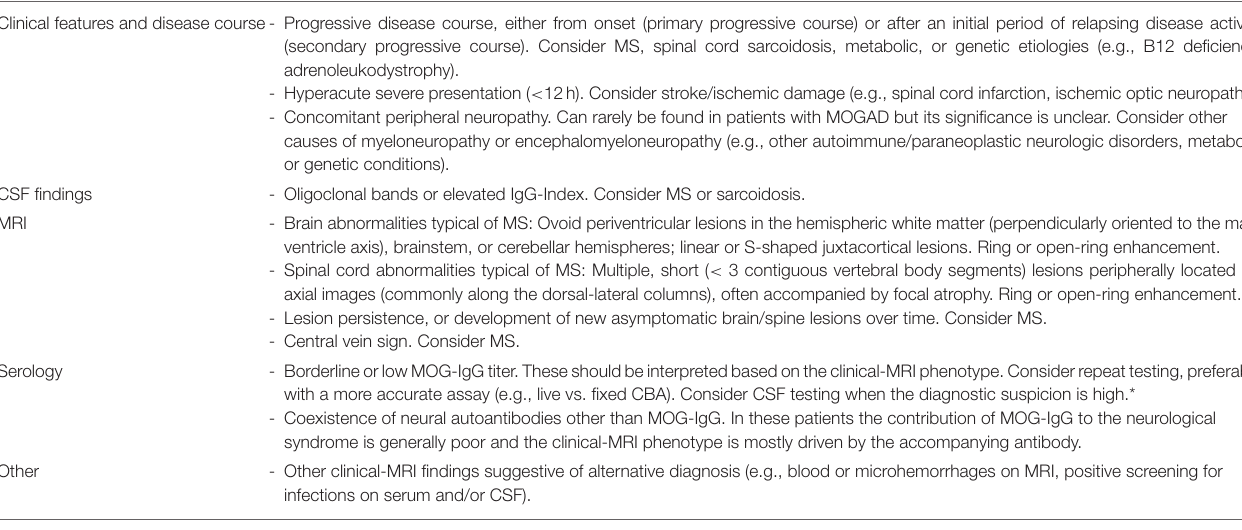
TABLE 2 | Major red flags for false MOG-IgG positivity in patients with suspected CNS demyelinating syndromes. Clinical features and disease course- Progressive disease course, either from onset (primary progressive course) or after an initial period of relapsing disease activity (secondary progressive course). Consider MS, spinal cord sarcoidosis, metabolic, or genetic etiologies (e.g., B12 deficiency, adrenoleukodystrophy). - Hyperacute severe presentation ( < 12h). Consider stroke/ischemic damage (e.g., spinal cord infarction, ischemic optic